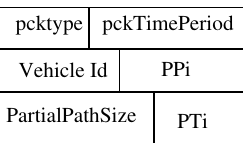
Figure 2. Vehicle packet design ( PP i : partial path, PT i : partial time path)